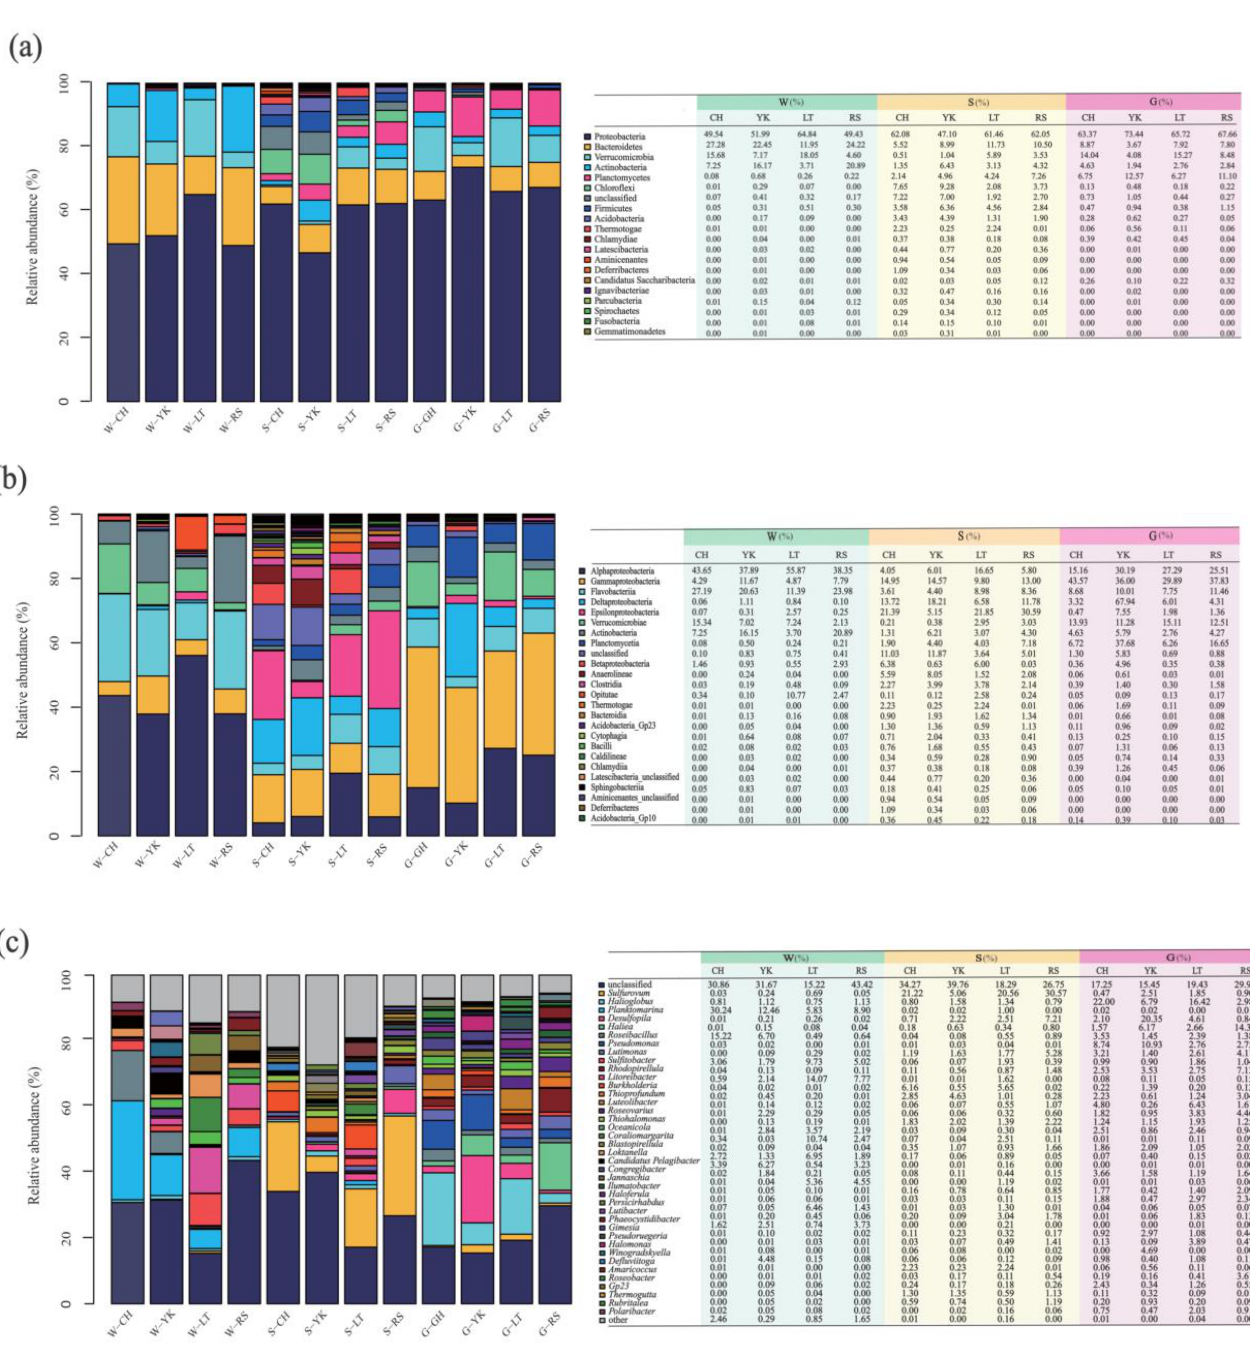
Figure 5. The relative abundance among multiple media (water (W), sediment (S), and the gut of Apostichopus japonicus (G)) in different areas. Relative abundances of the bacterial community in multiple media were determined at the ( a ) phylum, ( b ) class, and ( c ) genus levels. Alphaproteobacteria were the most predominant class in water from different areas, From the perspective of genus, Sulfurovum , Thioprofundum , Burkholderia , Desulfosarcina , Desulfopila , Lutimonas , and Mesorhizobium were the dominant bacterial genera in sediments in different areas. Specifically, Sulfurovum was the most predominant genus of different areas with relative abundance ranging from 5.06% to 30.57%. Burkholderia was the sec- ond most abundant genus in CH and LT with 6.16% and 5.65%, while Thioprofundum and Desulfopila were the second most abundant genera in YK and RS with 4.63% and 7.21%,